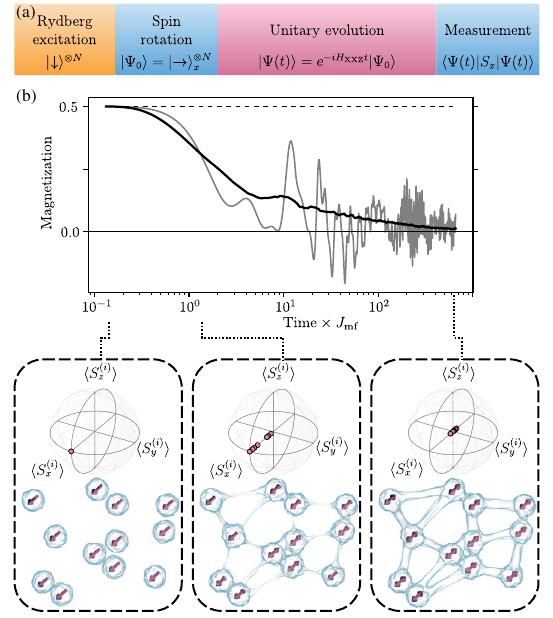
FIG. 1. Relaxation dynamics in a disordered quantum spin system. (a) Protocol for initialization and readout of the many- body spin system composed of Rydberg atoms. Spin states j ↑ i and j ↓ i correspond to two different Rydberg states. (b) Exact simulation of 12 spins interacting via a Heisenberg XXZ Hamiltonian. The plot shows the magnetization for a single realization (gray curve) and the disorder average over 1000 realizations (black curve) which relaxes as function of time given in units of the median of the mean-field interaction strengths J The dashed line indicates the mean-field prediction that does not relax. The microscopic expectation values of h S ð i Þ x i , h S ð i Þ y i , and h S ð i Þ z i for each spin are plotted at three different time steps on the Bloch sphere. The reduction of the expectation values (magneti- zation) is a consequence of the spreading of entanglement (visualized by the blue bonds between